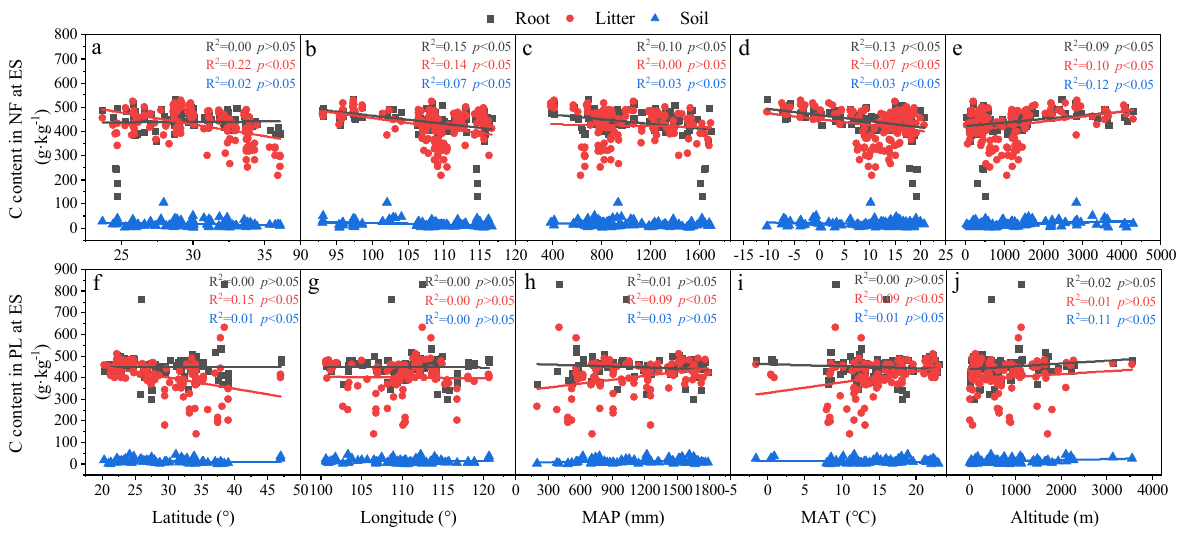
Figure A1. C content changes with latitude ( a , f ), longitude ( b , g ), mean annual precipitation (MAP) ( c , h ), mean annual temperature (MAT) ( d , i ) and altitude ( e , j ) in different forest origins in the early stage (ES). The number of forest sites are 149 and 102 for NF − ES and PL − ES, respectively.